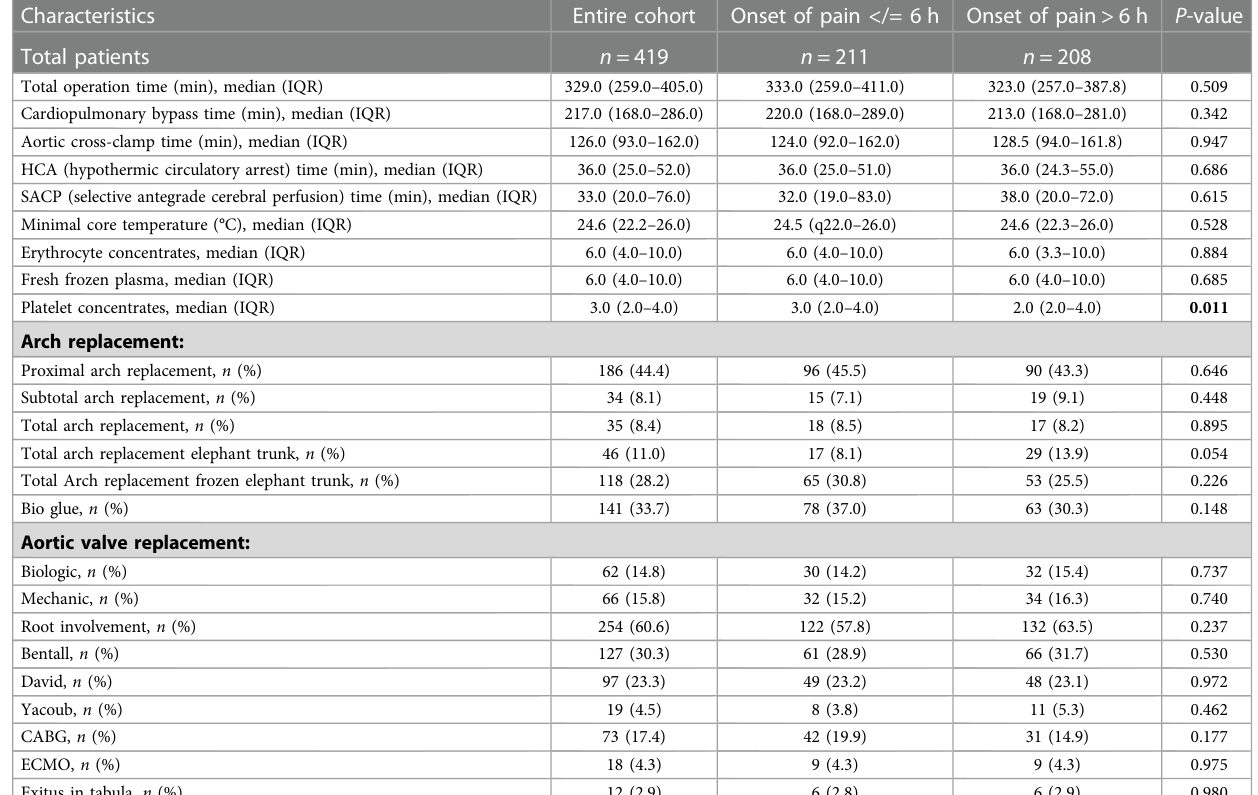
TABLE 3 Intraoperative data: SD, standard deviation; IQR, interquartile range; min, minute; HCA, hypothermic circulatory arrest time; CABG, coronary artery bypass graft; SACP, selective antegrade cerebral perfusion time.